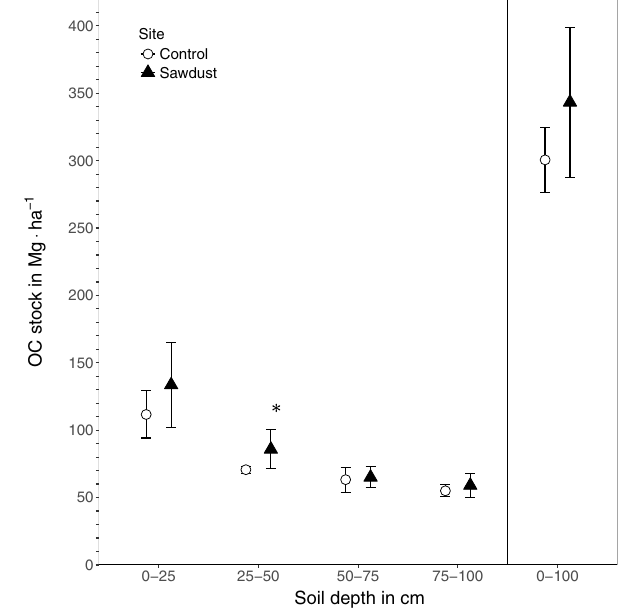
Figure 2. The organic carbon (OC) stocks of the sawdust and the control sites. Presented are the entire profile (0–100) and the four selected depth increments 0–25, 25–50, 50–75, and 75–100cm as the mean and the 95% confidence interval. ∗ The OC stock at the sawdust site is significantly ( α = 0 . 05, 1 − β = 0 . 8) larger compared to the control